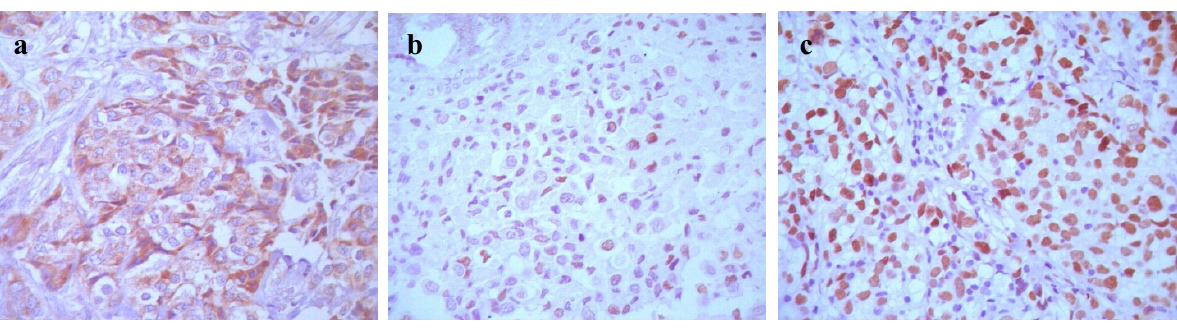
Figure 1. Immunohistochemical analysis of P-gp, CIAPIN1 and P53 protein expression in breast cancer tissues (41 cases): ( a ) expression of P-gp (SP, ×400); ( b ) expression of